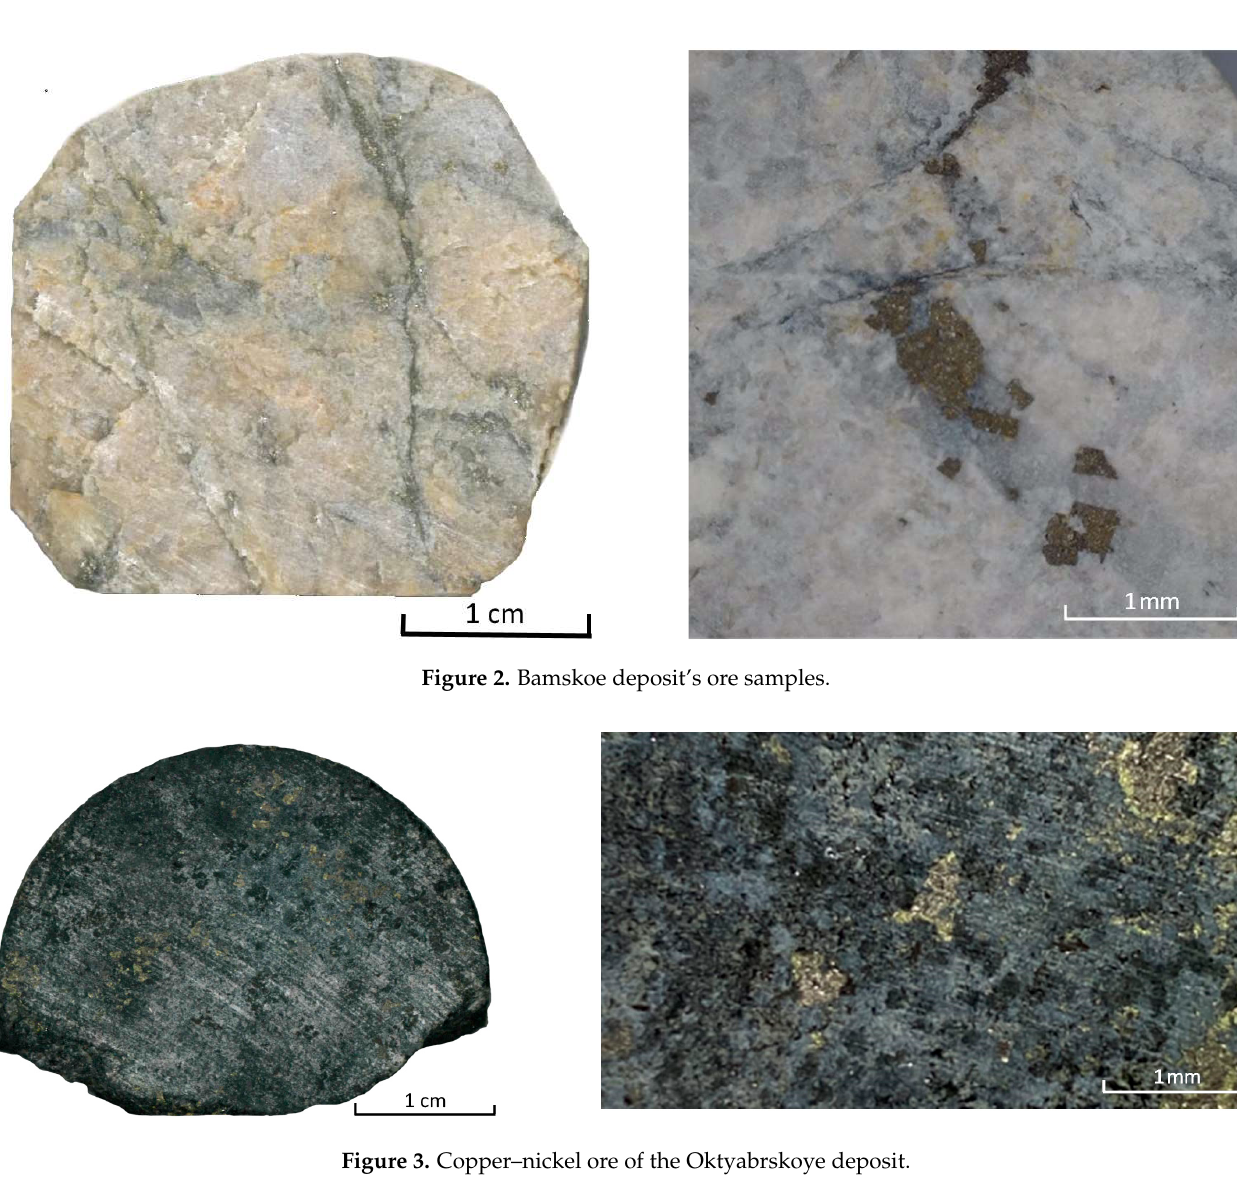
Table 1. Results of the study of the chemical composition of BDO.